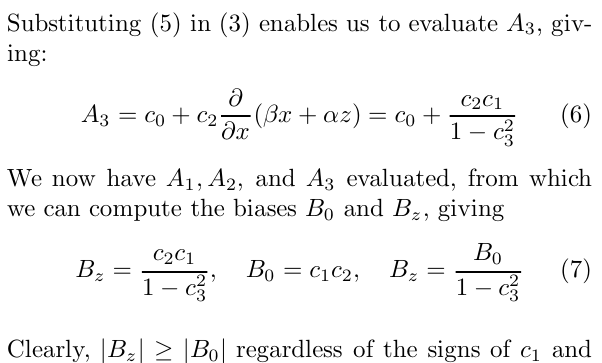
Figure 1: Linear model with instrumental variable Z and confounder U